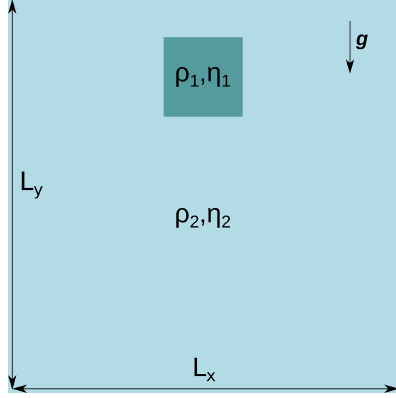
Figure B1. Falling block benchmark initial setup.